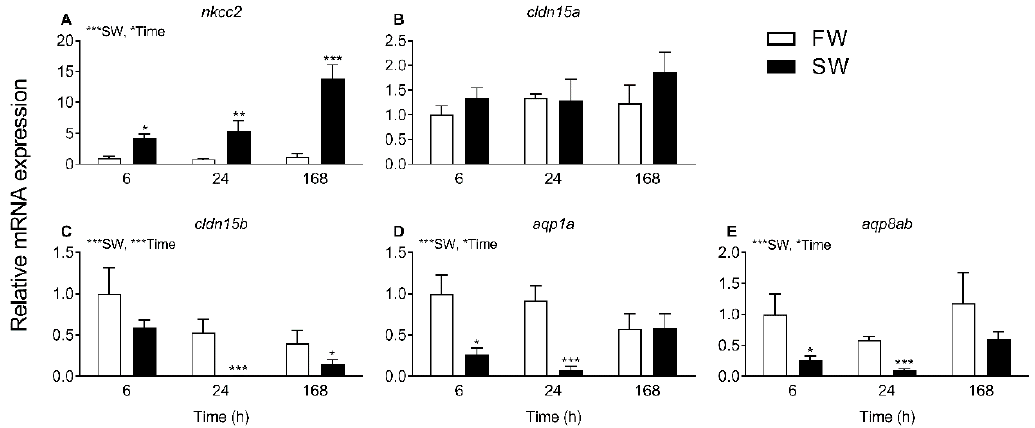
Figure 5. Effect of FW-to-SW transfer on intestinal transcript levels of nkcc2 ( A ), cldn15a ( B ), cldn15b ( C ), aqp1a ( D ), and aqp8ab ( E ). Fish were transferred from FW-to-SW (black bars) or FW-to-FW (white bars) as a control and sampled at 6, 24, and 168 h ( n = 6). Expression levels represent the mean value ± SEM relative to the 6 h-FW group. Asterisks next to SW and Time refers to the overall effects of a factor with two-way ANOVA. All targets with overall effects also had a significant interaction between factors, so the differences between time-matched groups were analyzed with Bonferroni multiple comparisons test (* p < 0.05, ** p < 0.01, *** p < 0.001) to identify the time-dependence of SW effects.